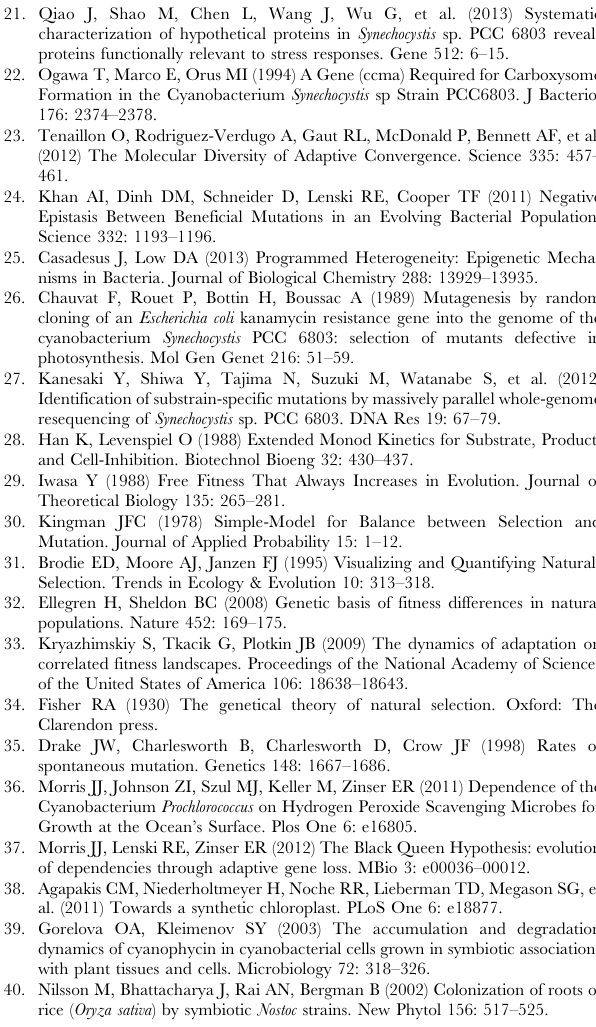
Figure S1: Toxic components in TCM1. Figure S2: Preculture for the evolution experiment. Figure S3: The specific growth rates as a function of the relative concentration of the toxic amino acids in each transfer round. Figure S4: Population dynamics in the evolution experiment. Figure S5: The difference between the approximate analytical solution (Equation 2) and the numerical simulation according to Equation 1. Table S1: Components of TCM1. Table S2: All detected mutations in the chromosome, relative to the reference (NC_000911.1; Synechocystis sp. PCC 6803 chromosome, complete genome), by the genomic